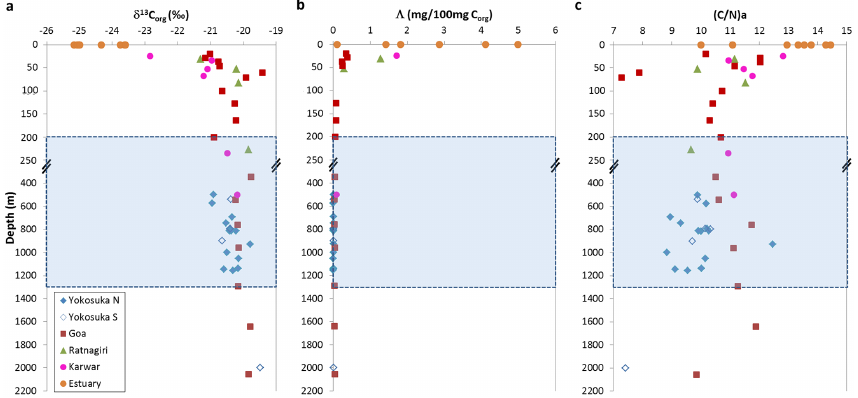
Figure 4. Plots against station depth (m) of (a) stable C isotopic composition ( δ 13 C org , ‰), (b) total lignin phenol yield ( (cid:51) , mg100mg − 1 C org ) and (c) molar ratios of organic C to total N [(C/N)a], for surficial sediments from estuary, shelf and slope sites. Shaded area indicates approximate depth of permanent mid-depth OMZ (< ∼